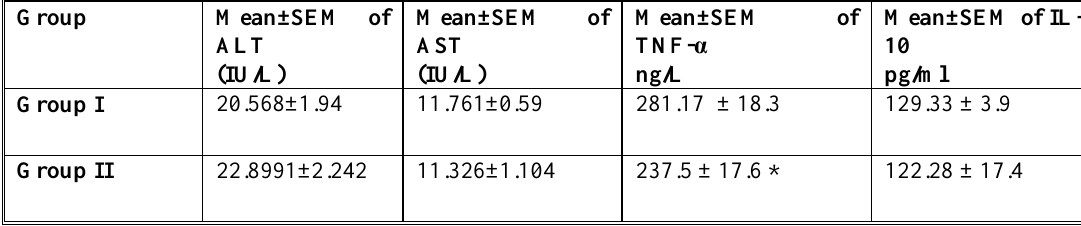
Table1. Effect of therapeutic dose of lornoxicam on liver tissue enzymes (ALT and AST) and cytokines (TNF-α, IL-10) levels in male rats